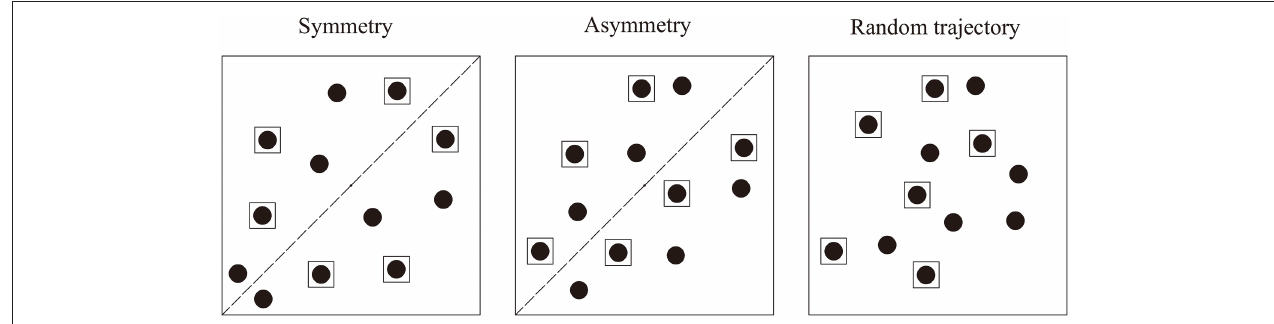
FIGURE 2 | Three target position conditions in Experiment 1: Symmetry, Asymmetry, and Random trajectory. Disks inside the black squares were targets.